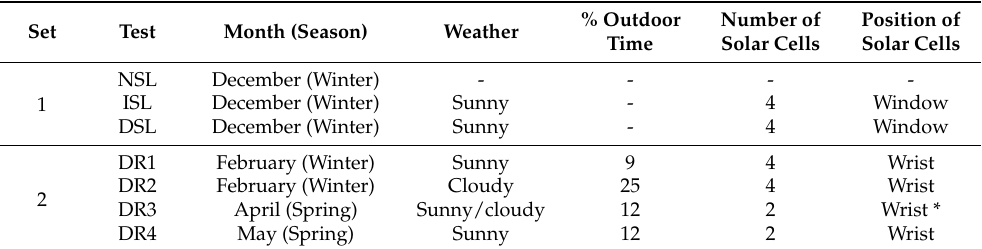
Table 1. Summary of the characteristics of the tests. Set Test Month (Season) Weather